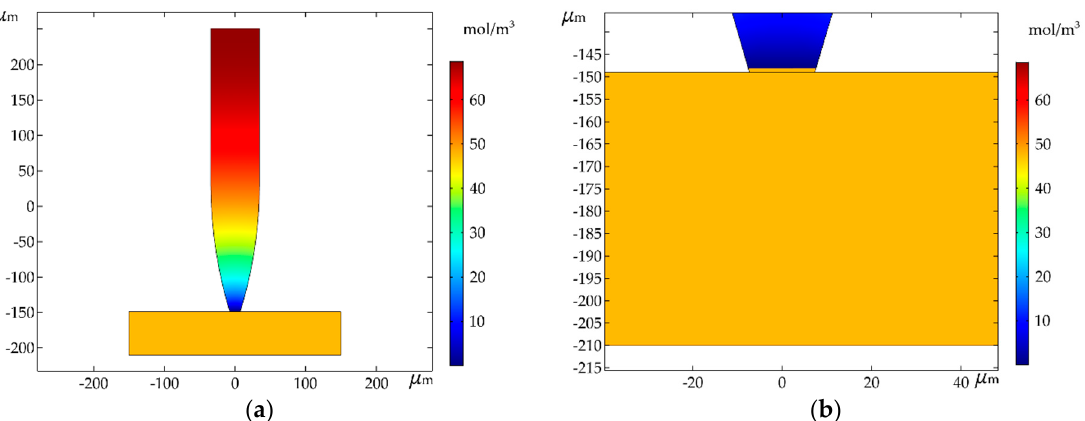
Figure 8. ( a ) Simulation results: distribution of copper ion concentration in the pipette after 100 s; ( b ) local enlargement of the simulation results.